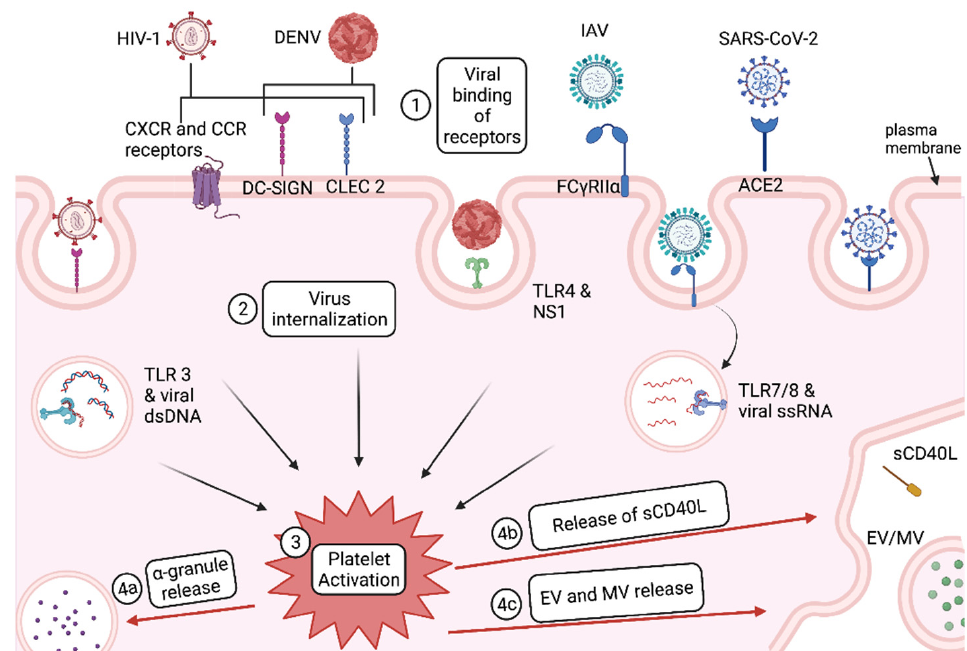
Figure 1. Viral entry and activation of platelets. 1. Human immunodeficiency virus-1 (HIV-1), dengue virus (DENV), influenza A virus (IAV), and severe acute respiratory syndrome coronavirus 2 (SARS-CoV-2) bind receptors on the platelet plasma membrane as well as within endosomes. Receptors involved include CXCR/CCR receptors, DC-SIGN, CLEC 2, FC γ RII α , ACE2, and TLRs 3/4/7/8. 2. Upon viral binding, viruses are internalized into the platelets. 3. Both viral binding and virus internalization lead to platelet activation. 4. Platelet activation results in platelet effector functions, such as 4a. α -granule release, 4b. release of soluble CD40L (sCD40L), and 4c. extracellular vesicle (EV) and microvesicle (MV) release. Created with BioRender.com (30 December 2021).